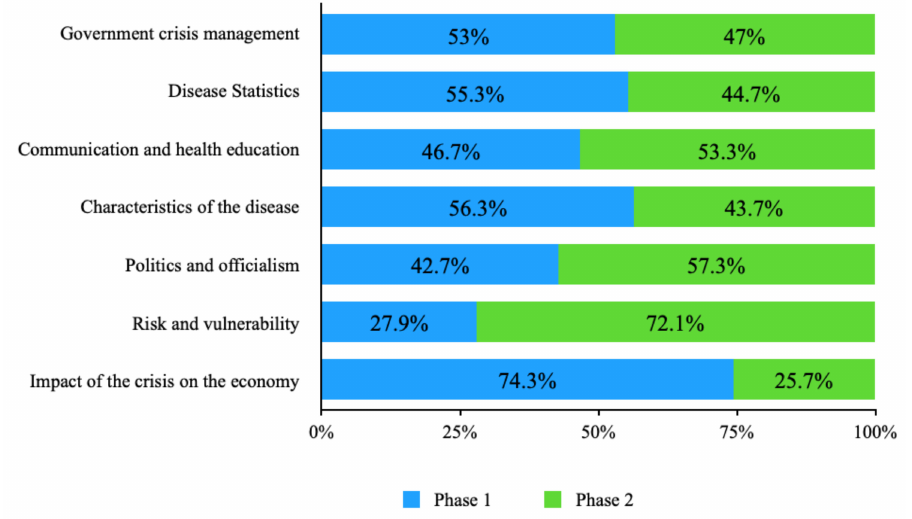
Figure 2. Percentage distribution of questions in phases 1 and